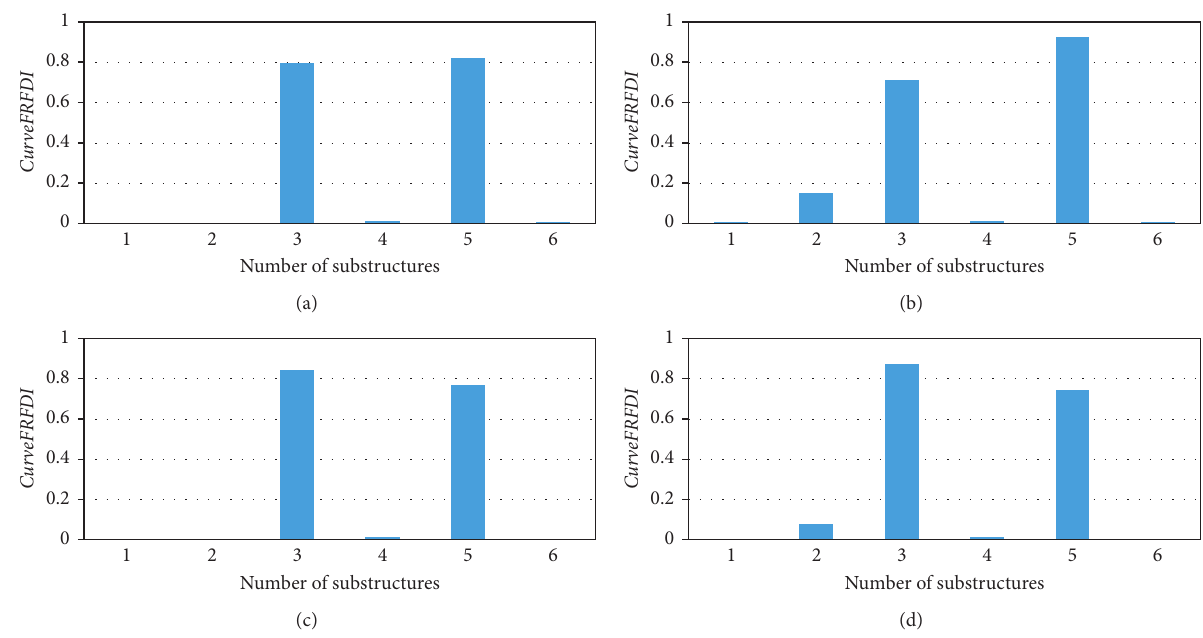
Figure 23: CurveFRFDI values for (a) case Dam_3F10%&5F15%, (b) case Dam_3F10%&5F20%, (c) case Dam_3F15%&5F10%, and (d) case Dam_3F20%&5F10%.